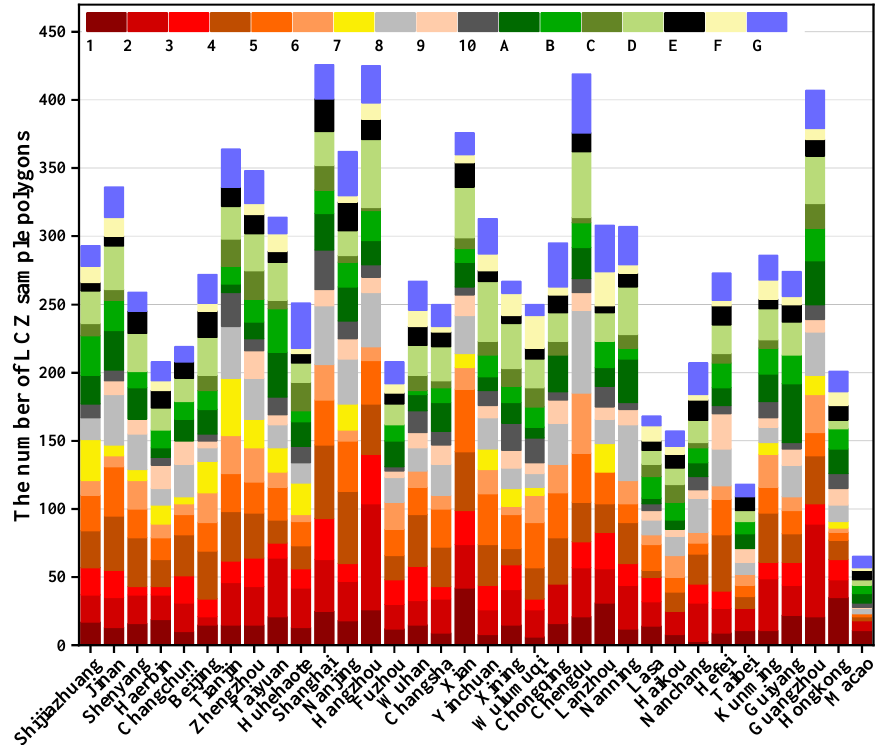
Figure 4. The number of sample polygons for different LCZ types in 34 Chinese cities.